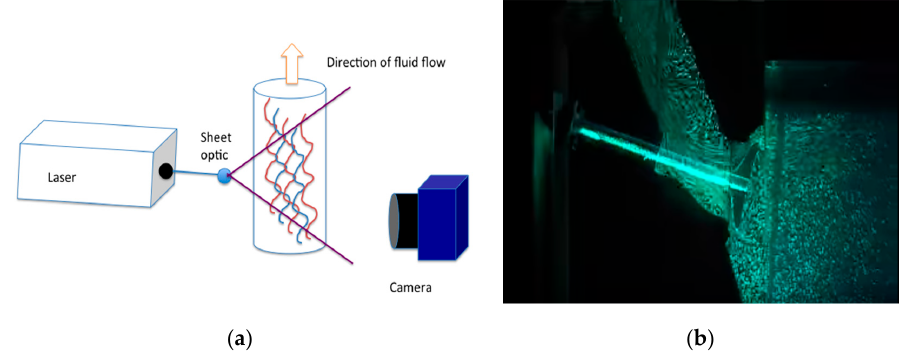
Figure 4. ( a ) Particle image velocimetry (PIV) requires a camera, laser, seeding particles, and optically clear “phantom.” The laser refracts off of the seeding particles and sequential images elucidate specific fluid dynamics; ( b ) Real-time snapshot of a PIV model. Seeding particles are illuminated by the laser and a high resolution camera takes sequential images. Data is analyzed by PIV software. (Courtesy of University of Brighton Youtube Channel [23]).